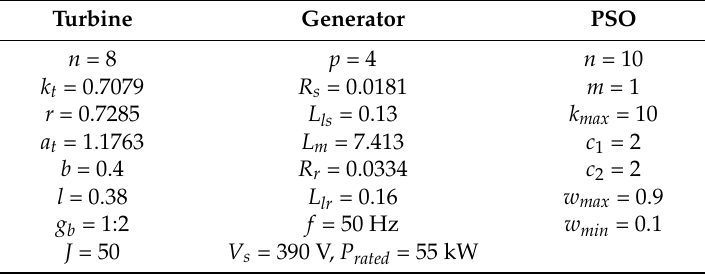
Table 1. Turbine, Generator and particle swarm optimization (PSO) parameters.